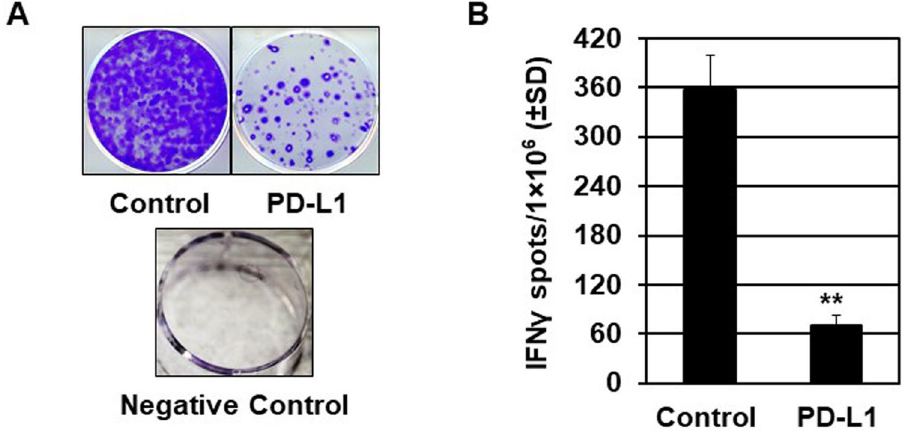
Figure 4. Modulation of immune function in mice treated with PD-L1 protein. Pmel-1 mice were treated with murine PD-L1 fusion protein or IgG control for 6 weeks. One weeks after the final treatment, splenocytes were harvested and incubated for 24 hours with or without peptide. ( A ) The proportion of IFN γ -secreting cells was measured in the presence of 30 μ g/ml peptide. ( B ) IFN- γ in the PD-L1 protein treatment group decreased